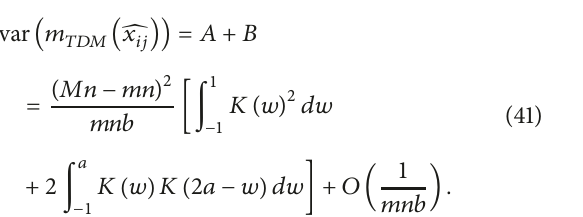
Table 2: Summary results of